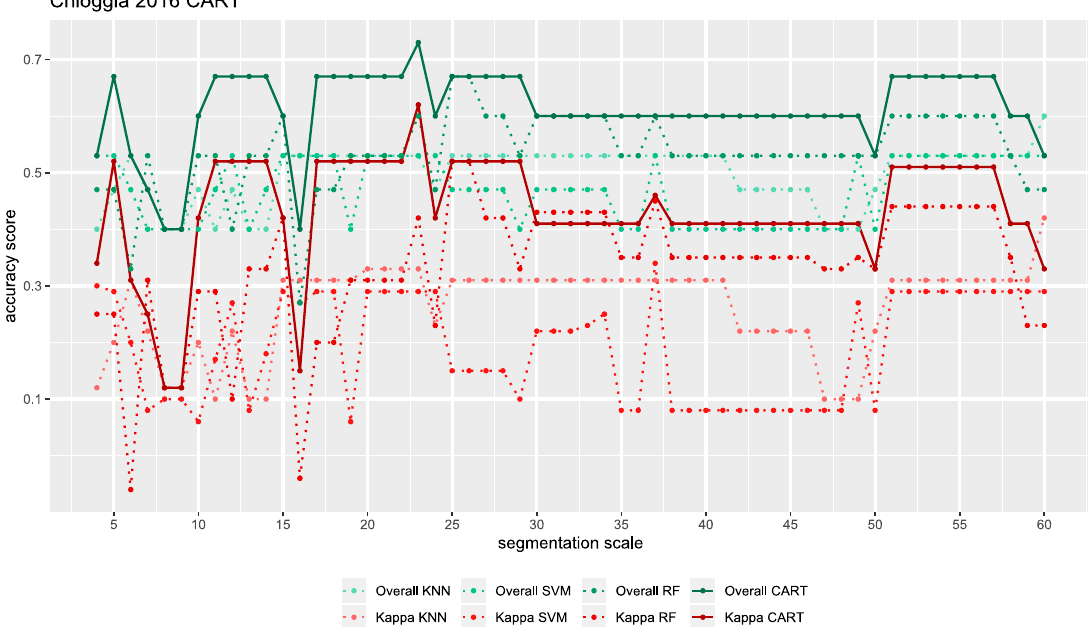
Figure A3. Overall and kappa accuracy assessment charts for scales of multiresolution segmentation 4–60. Chioggia 2016 dataset divided for four classes, CART feature-selection algorithm.